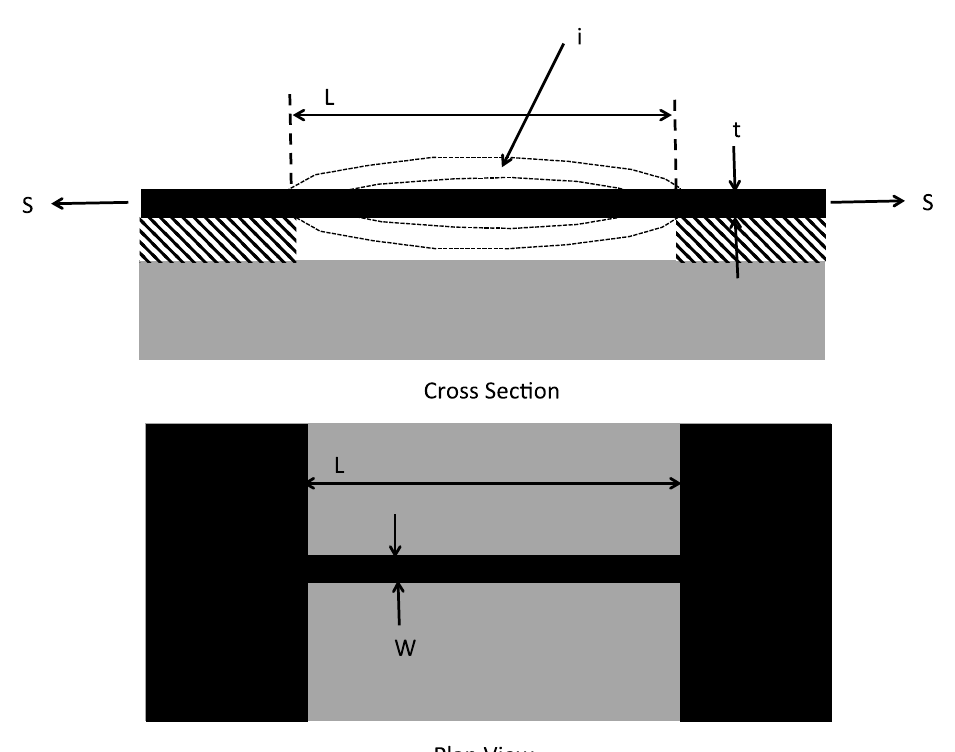
Figure 3. Illustration of Beam Resonator.